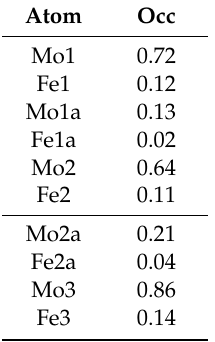
Table 2. Occupancy factor of the partially occupied atoms in Fe 0.43 Mo 2.56 SbO 9 .